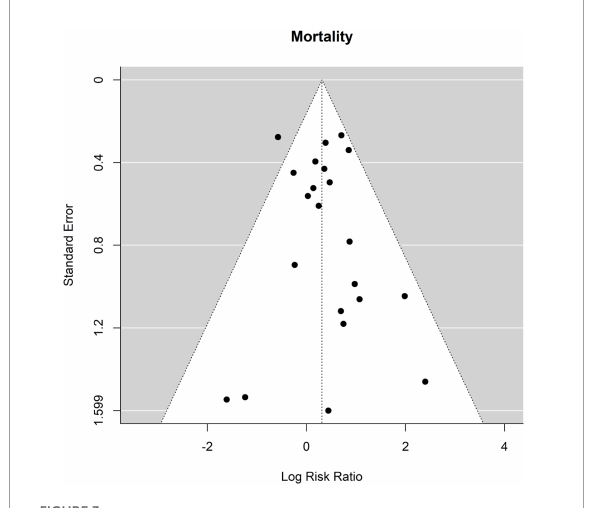
FIGURE3 Relative risk of mortality in patients undergoing aortic interventions with conventional elephant trunk (ET) vs. frozen elephant trunk (FET). Funnel plot.